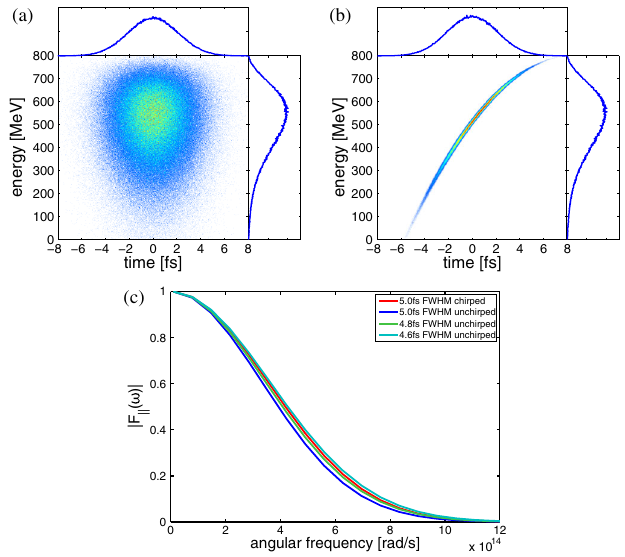
FIG. 3. Influence of a longitudinal phase-space correlation. Longitudinal phase-space distribution for (a) the case of an uncorrelated bunch and (b) for the case of a correlated bunch. (c) Simulated CTR spectra corresponding to the distributions shown in (a) and (b) for different FWHM